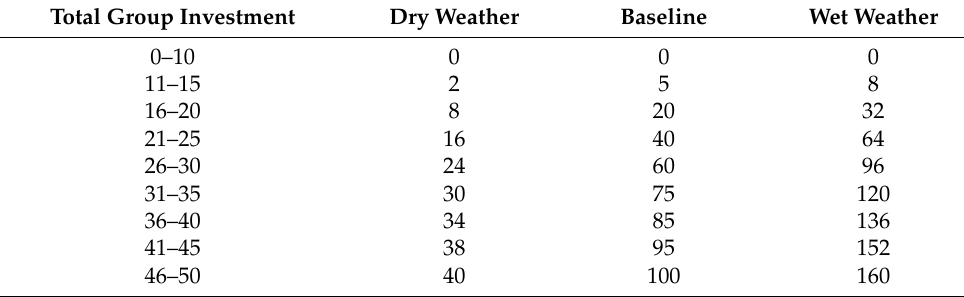
Figure 1. Location of players (A–E) along an irrigation channel (adapted from [39]). Table 1. Available water quantity according to total